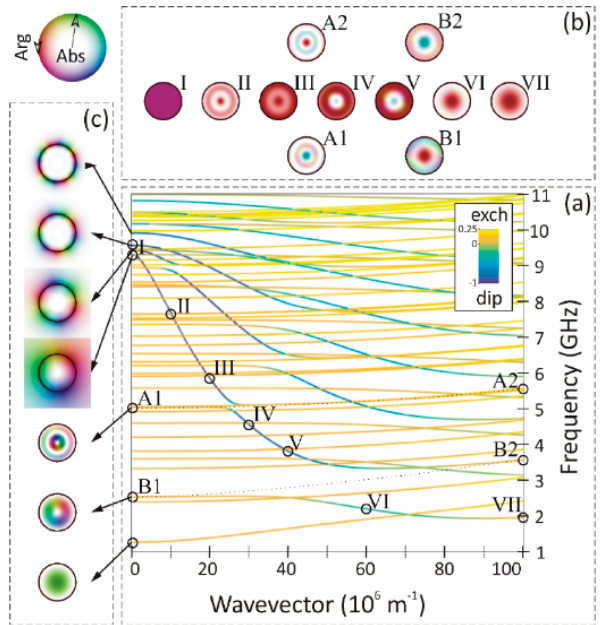
Figure 1. ( a ) Dispersion relation of cylindrical (60 nm-radius) Ni nanowire magnetized along its axis in the absence of an external field and the profiles of ( b ) dynamic magnetization, and ( c ) magnetostatic potential for selected spin wave